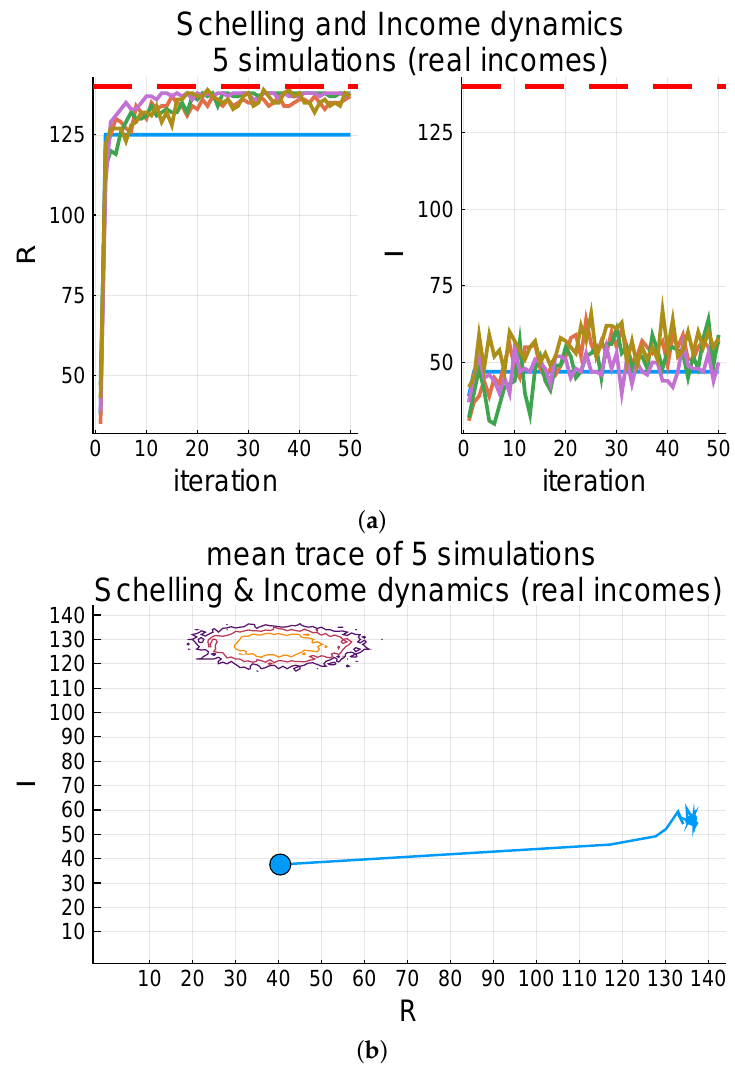
Figure 4. The trajectory of the macrostate over 5 independent simulations. Subfigure ( a ) shows the trajectory of the overall grid homogeneity over simulation iterations for R and the grid income homogeneity I for the same iterations. Subfigure ( b ) shows the trajectory over both homogeneity variables with the contour levels of the sampled density of the space used to calculate the entropy of each point in the trajectory. Equation (9) was used for residential